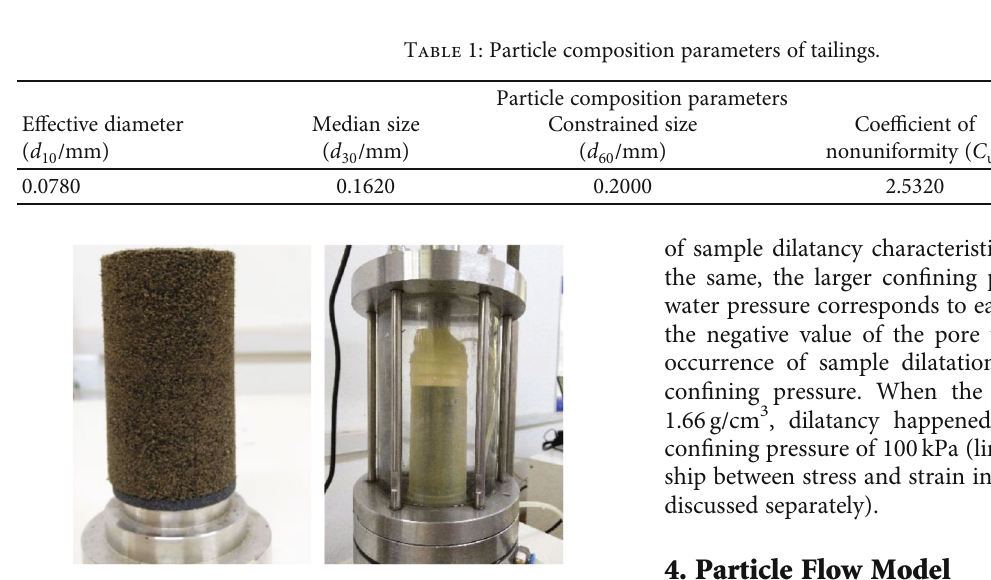
Figure 1: Samples before and during loading.